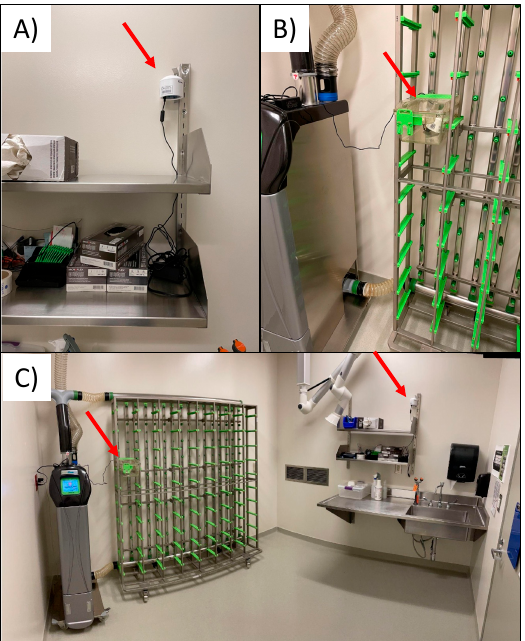
Figure 2. Placement of indoor sensors including ( A ); indoor wall location, ( B ); indoor HEPA cage location, and ( C ); room where both indoor sensors were located.